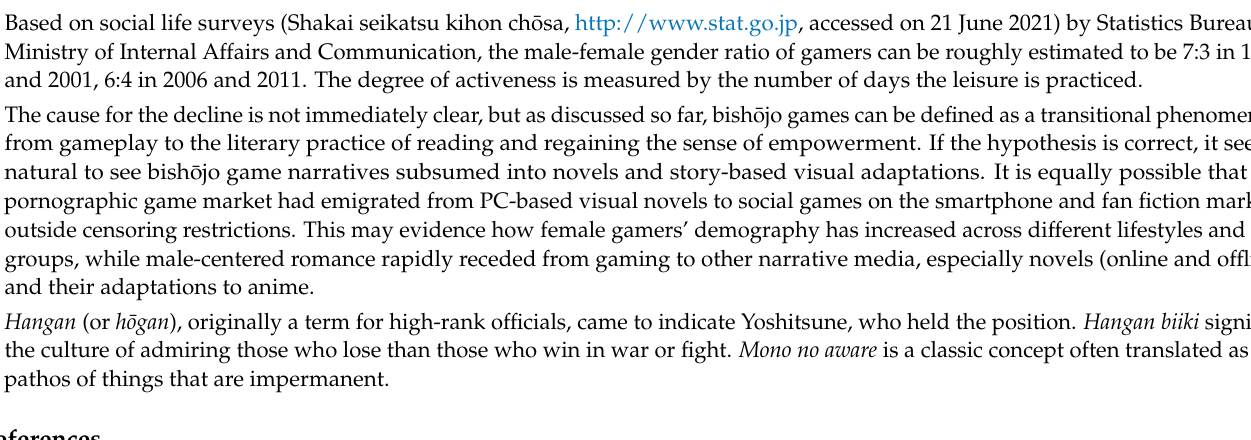
and their adaptations to